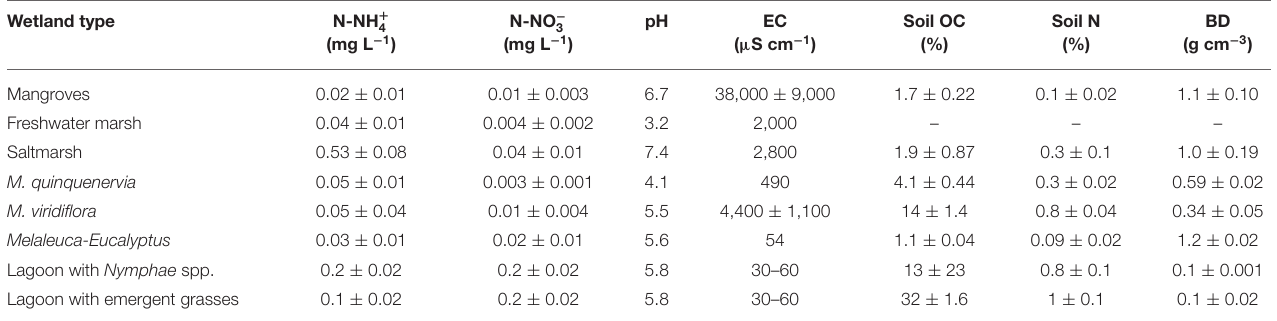
Values are mean ± standard error of three samples per site for nutrients, soil OC, soil N and BD.